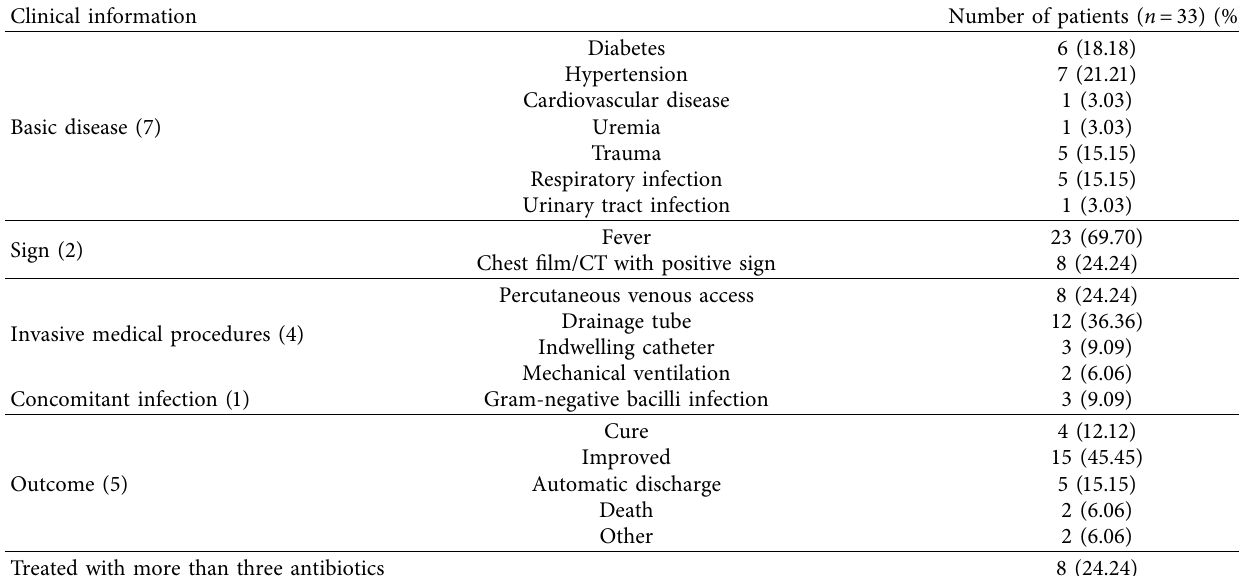
Table 5: Clinical data of 33 patients with S. aureus infection. Clinical